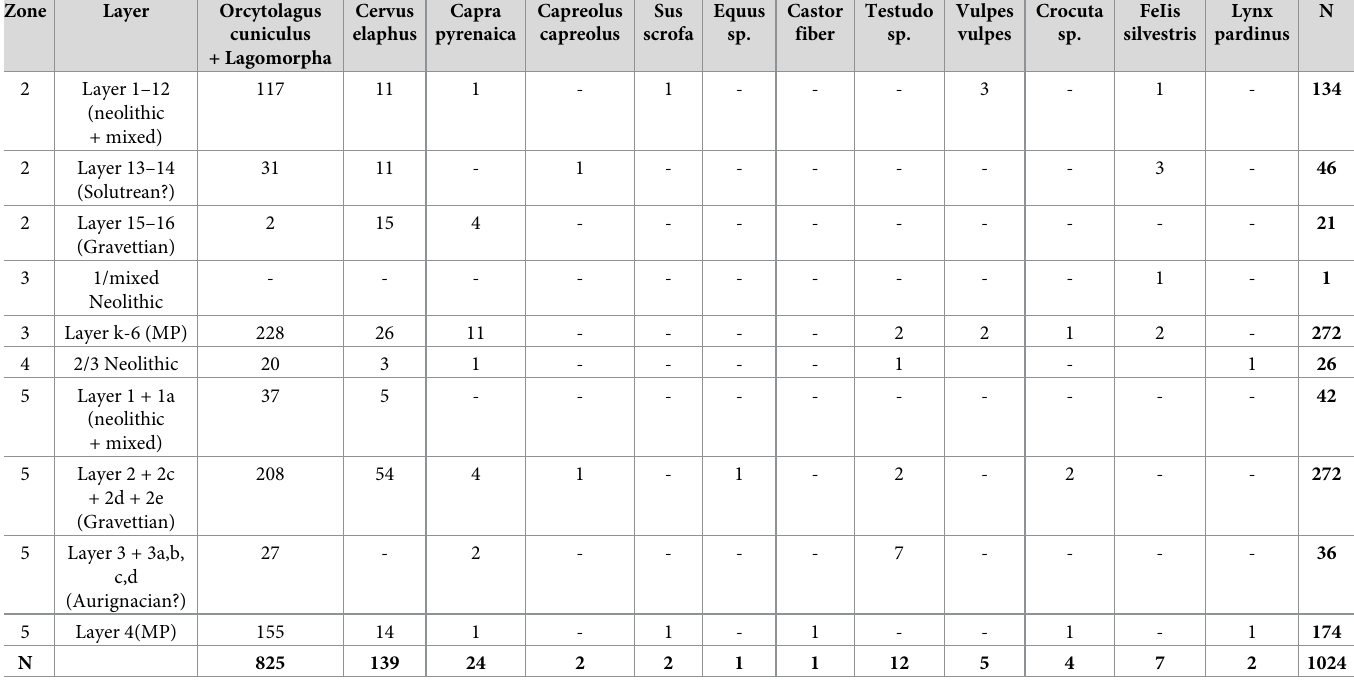
Table 5. Faunal remains (NISP) from excavation zones 2–5 divided by